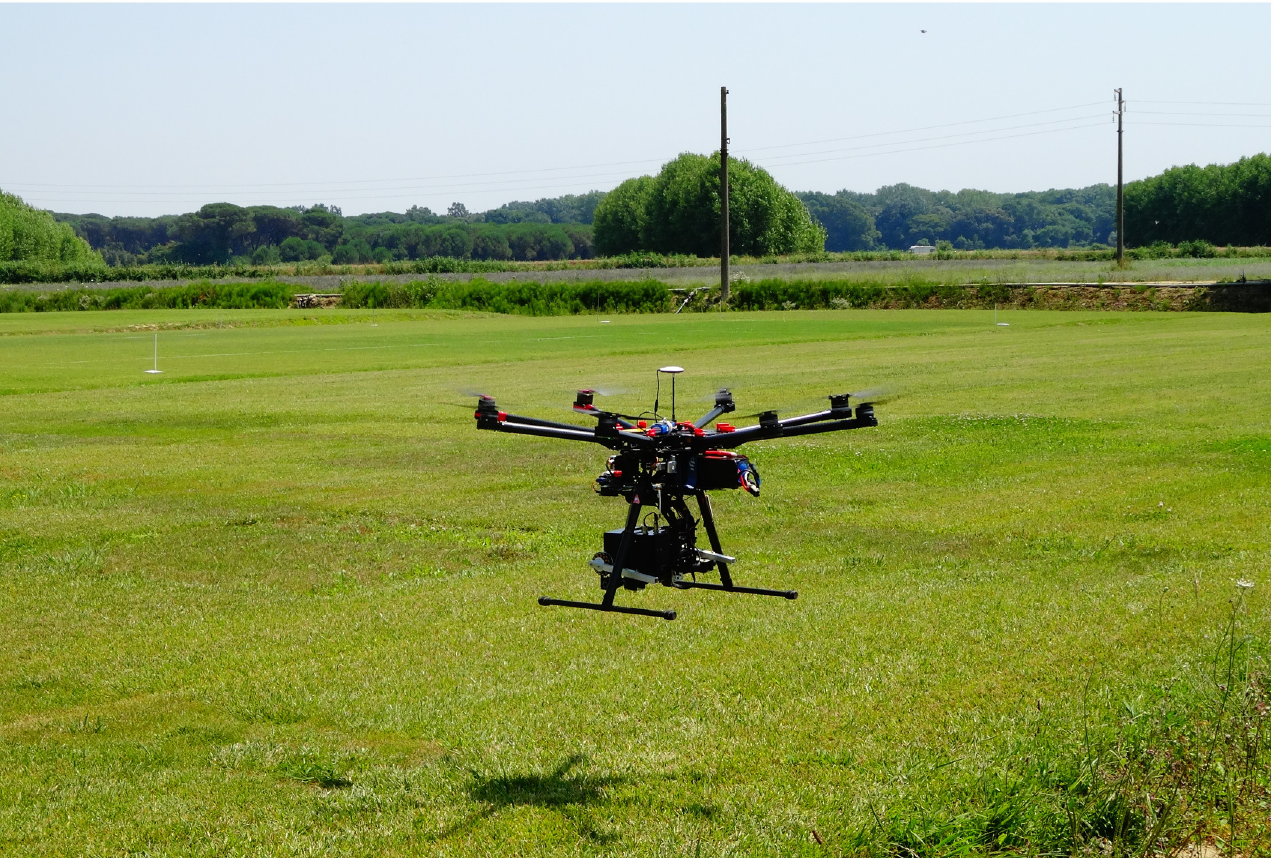
Fig 1. The UAV during flight operations (July 6, 2015; Pisa, Italy; 43°40 ’ N, 10° 19 ’ E, 6 m. a.s.l.) and a detail of the vehicle DJI S1000